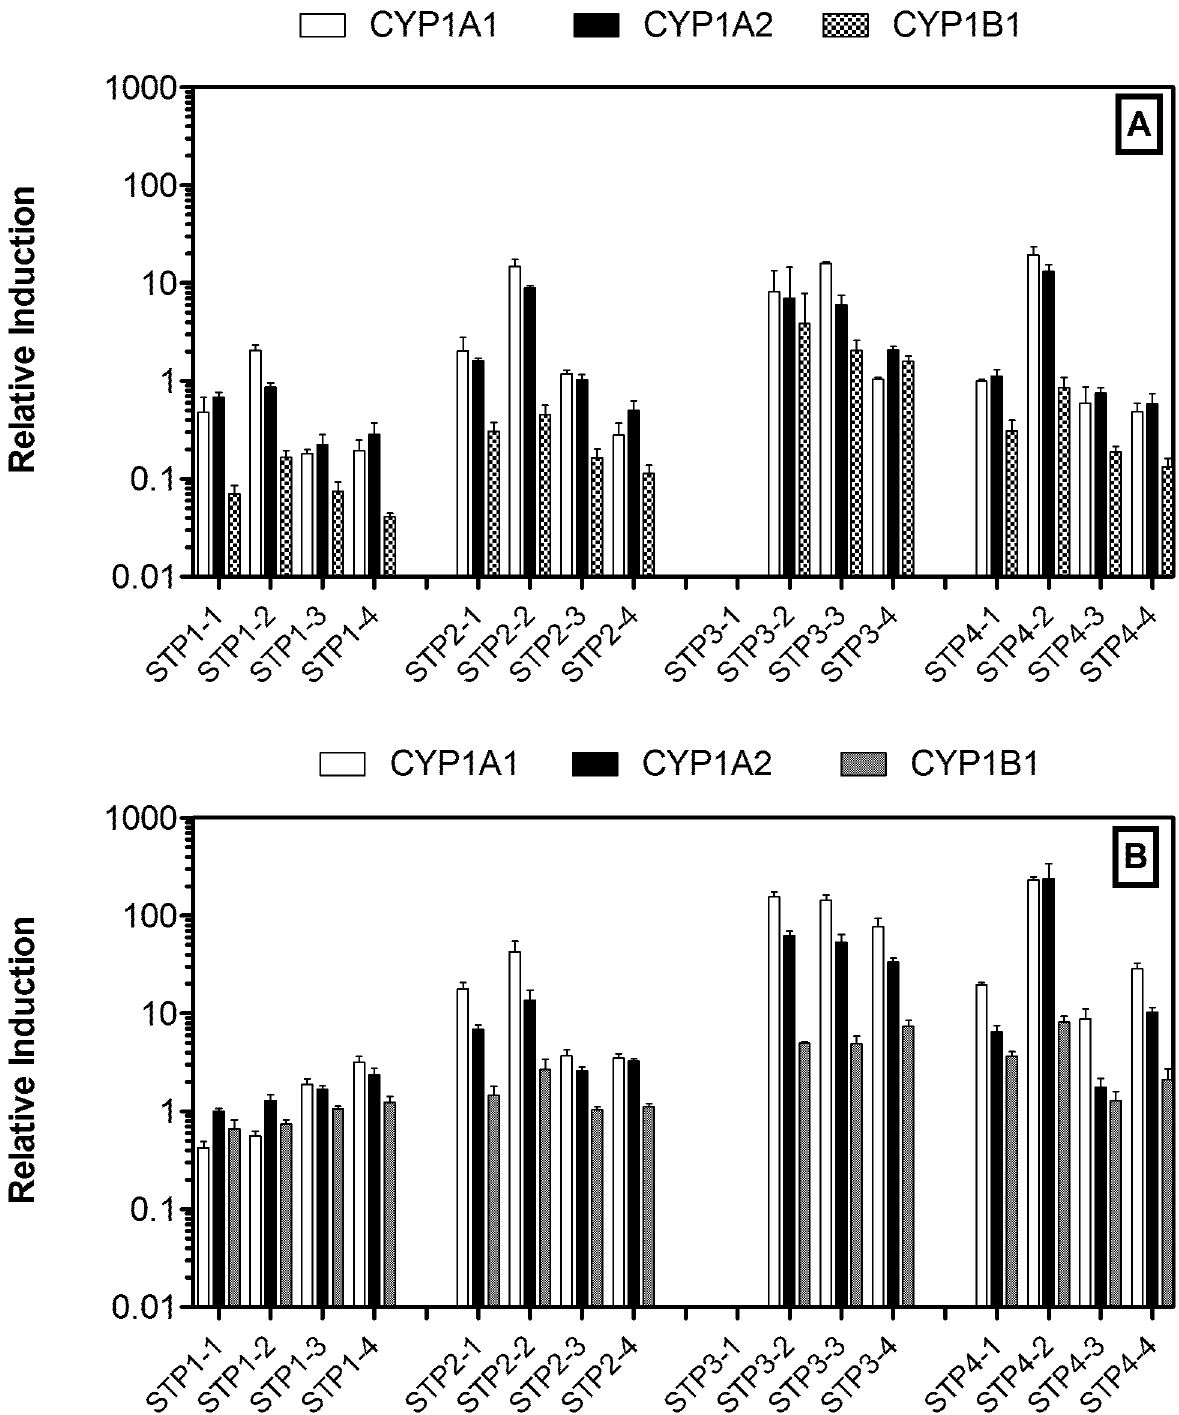
Fig 2. Comparison of CYP1 gene expression in rat hepatocytes exposed to wastewater extracts from STPs. A: Pre-monsoon, B: Monsoon. Data are reported as means ± SD (standard deviation). STPx-y: x is the type of STP, y is the treatment step [equalization (step 1), aeration (step 2), settling (step 3), and outlet (step 4)]. The data for STP3-1 were not